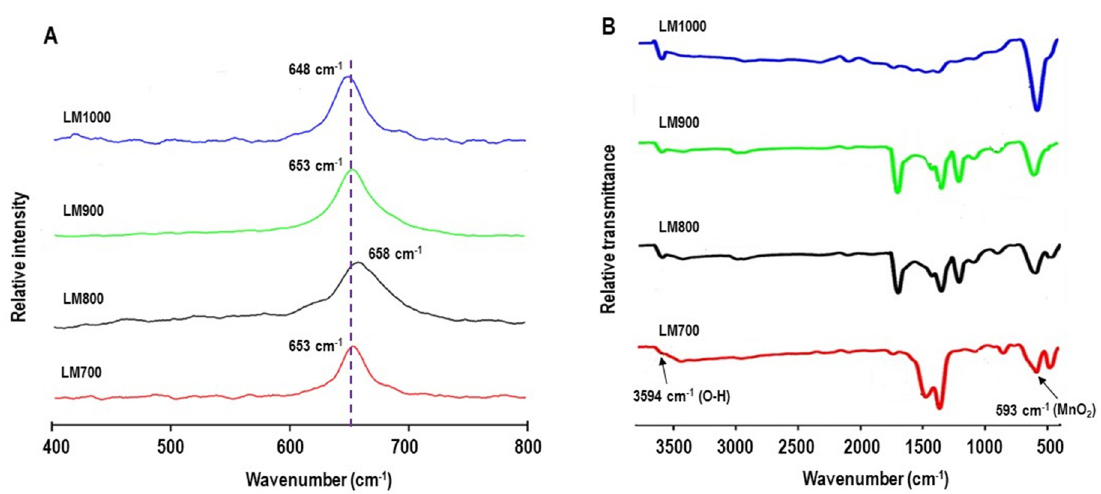
Figure 4. ( A ) Raman and ( B ) infrared spectra of the samples.